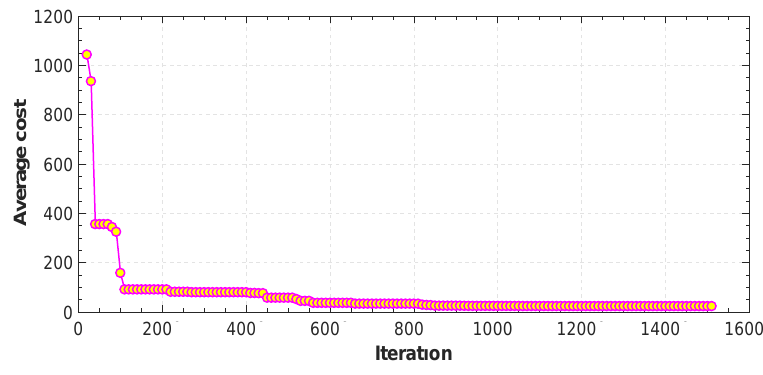
Figure 19. Average cost function vs. iteration for CMS.